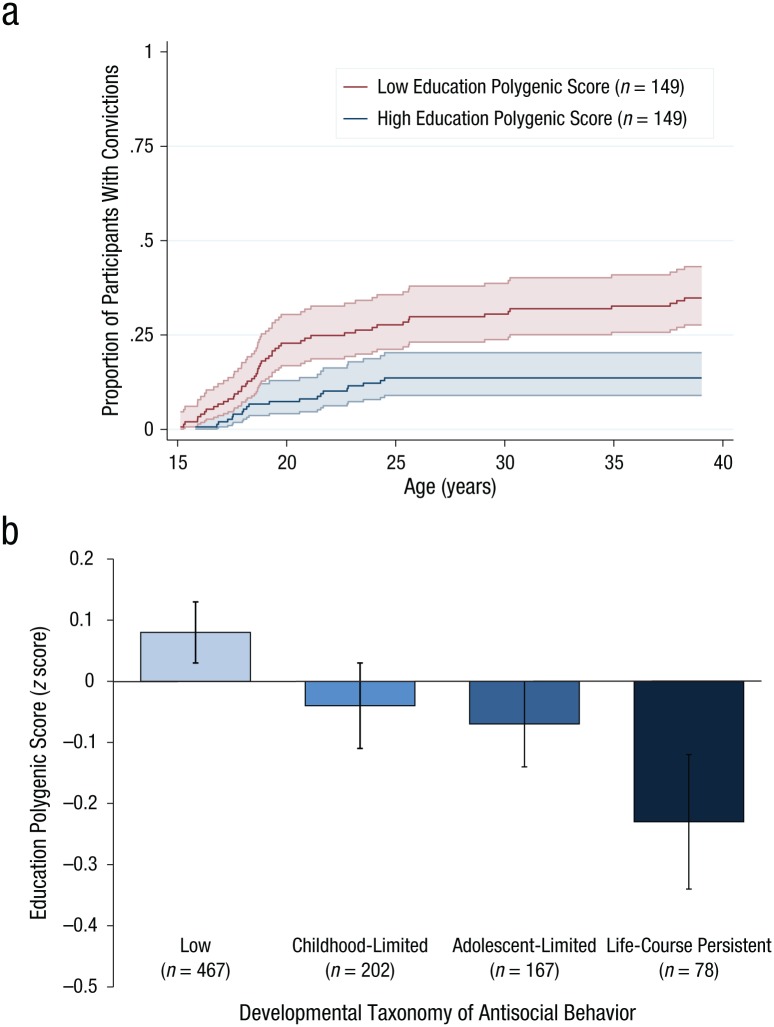
Association between polygenic score for education and the timing and persistence of
antisocial behavior across the life course. Panel (a) depicts the proportion of
Dunedin participants with convictions by age (Kaplan Meier failure functions) among
participants with low (< 1 SD below the mean) and high (> 1
SD above the mean) polygenic scores for educational attainment.
Shaded areas show 95% confidence intervals. Panel (b) shows mean differences in
polygenic score across four developmental subtypes of antisocial behavior in the
Dunedin cohort, following Moffitt
(1993b). Error bars reflect standard errors.